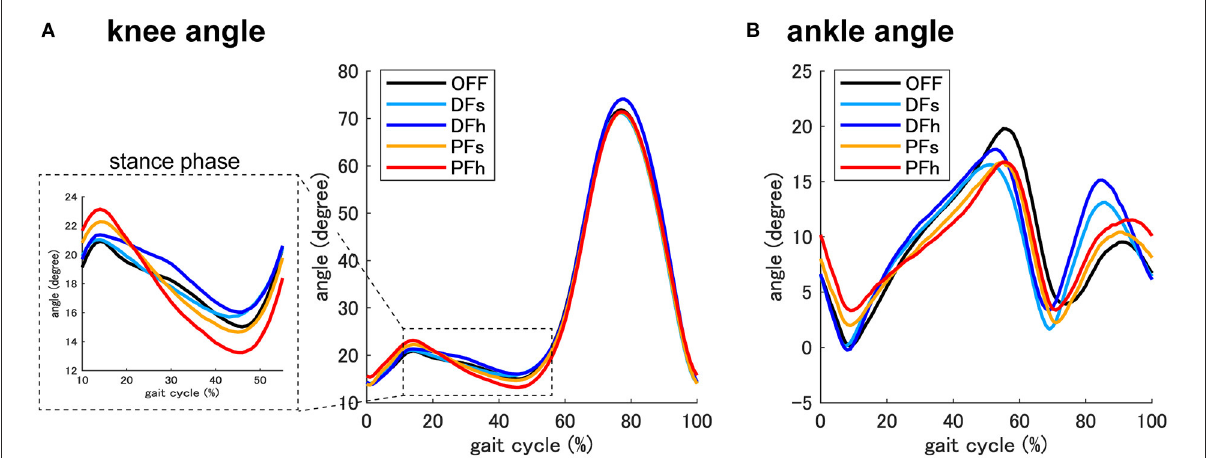
FIGURE2 Knee and ankle joint angle. The averaged joint angle of the knee (A) and ankle (B) throughout the gait cycle (from the heel strike to the next heel strike of the right leg) in each condition. The dotted square shows a magnified view of the joint angle of the knee. DFs, controlled with slow ankle dorsiflexion; DFh, controlled with high ankle dorsiflexion; PFs, controlled with slow ankle plantar flexion; PFh, controlled with high ankle plantar flexion; OFF, not controlled.